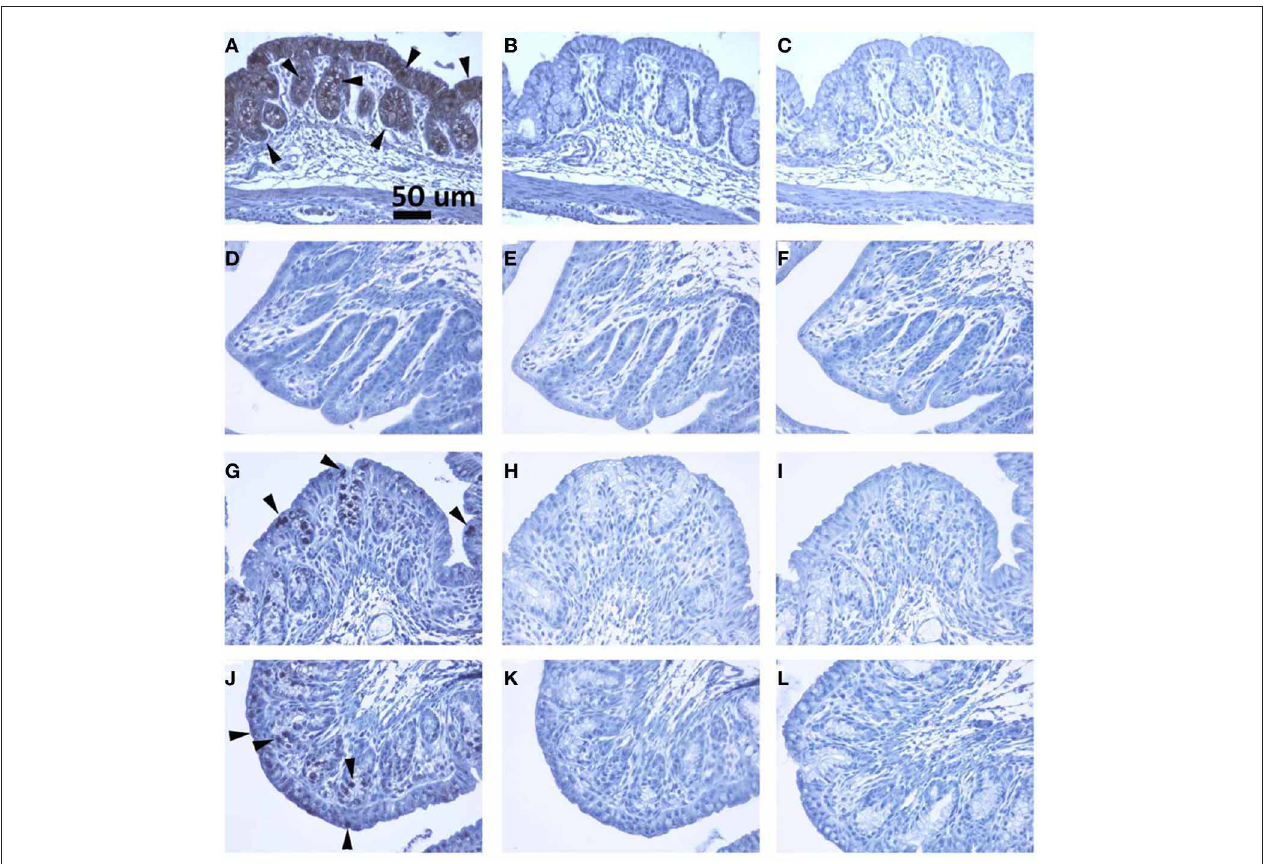
FIGURE 6 | (A–C) , (D–F) , (G–I) and (J–L) are colon sections from naïve, Stx2, heat-inactivated Stx2 and Stx2 mutant treated rabbits, respectively. (A, D, G and J) are sections stained with anti-Gb 3 antibody. Strong signal in A (luminal layer) and less intense stain in G and J can be recognized, whereas no signal is detected in D (Stx2 treated). Arrowheads show